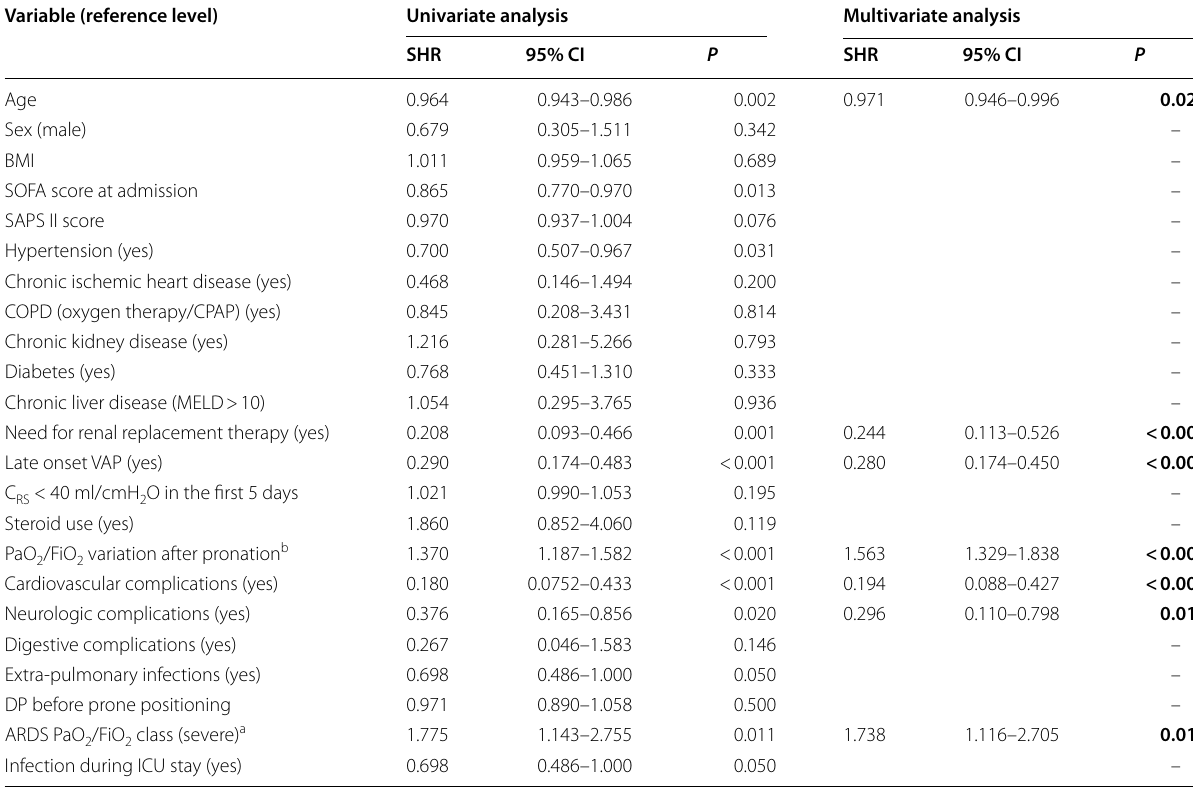
Significant P values are highlighted in bold SHR subdistribution hazard ratio ( SHR 1 no association between the covariate and the corresponding cumulative incidence function, SHR > 1 an increase of the covariate value is associated with an increased risk of liberation from mechanical ventilation, SHR < 1 implies the opposite), DP driving pressure, VAP ventilator associated pneumonia, C RS compliance of the respiratory system, BMI Body mass index, COPD chronic obstructive pulmonary disease, CPAP continuous positive airway pressure, ICU intensive care unit a Per class points increase, class 1 severe ARDS, class 2 moderate ARDS. Reference level in branches for each covariate = = b Per quartile variation, 1st quartile (< 19%), 2nd quartile (19–49%), 3rd quartile (49–100%), 4th quartile (> 100%)